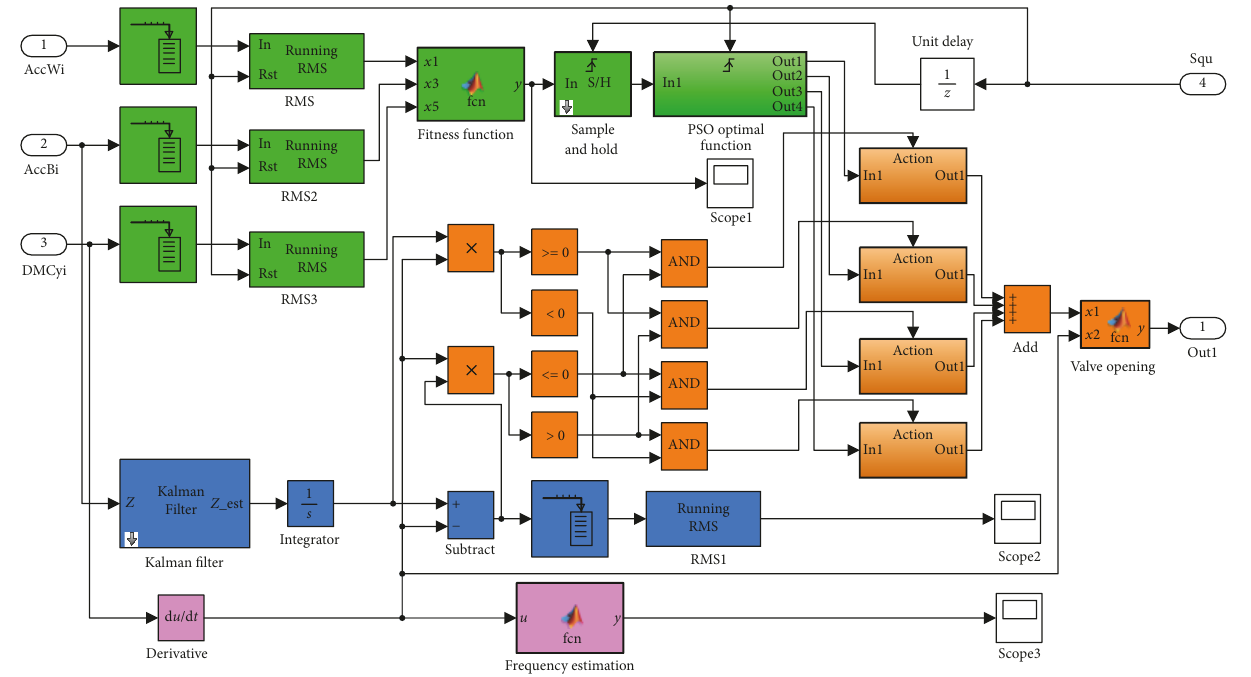
Figure 5: Flowchart of Simulink model using the PSO algorithm and control algorithm.